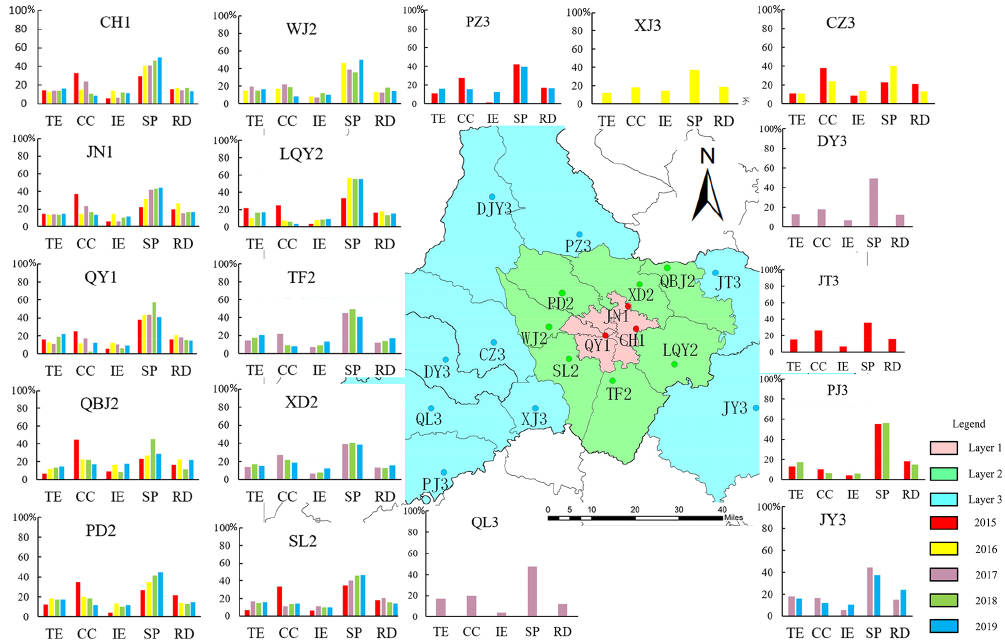
Figure 7. Spatiotemporal variations of source contributions to total mass of PM 2 . 5 in Chengdu. (TE, CC, IE, SP, and RD represent traffic emission, coal and biomass combustion, industrial emission, secondary particles, and resuspended dust, respectively.)